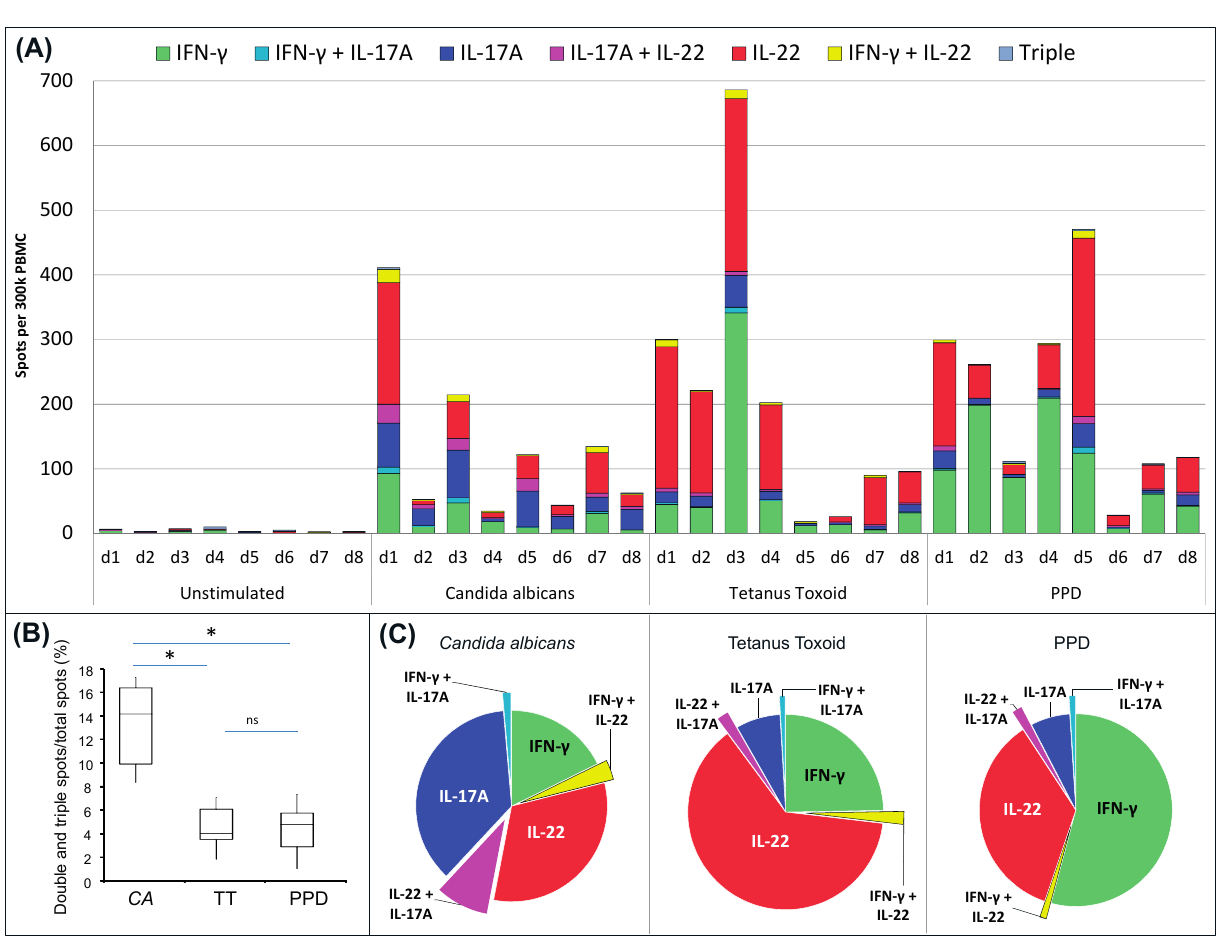
Figure 3. IFN- γ /IL-17A/IL-22 triple FluoroSpot analysis of PBMC responses to CA, TT and PPD. PBMC incubated with stimuli or medium alone were analyzed for spots representing cells secreting single, double and triple combinations of IFN- γ , IL-17A and IL-22. ( A ) The bars represent individual responses (n = 8) to all antigens divided into single, double or triple spots; ( B ) Analysis of the proportion of double- and triple-stained spots induced by the different antigens shown for all eight donors. The box plot show median (line in box), min and max (vertical lines), and 25 and 75 percentiles (box) for CA, TT, and PPD stimulation (n = 8). Statistical significance is indicated as * ( p < 0.01) or ns (not significant); ( C ) Average proportion of single and double spots for each cytokine/cytokine combination per total number of spots. PBMC with responses below 40 spots in total were excluded for the analysis (1 donor for CA, 2 donors for TT and 1 donor for PPD) to avoid an impact of subtle differences in spot numbers in the low